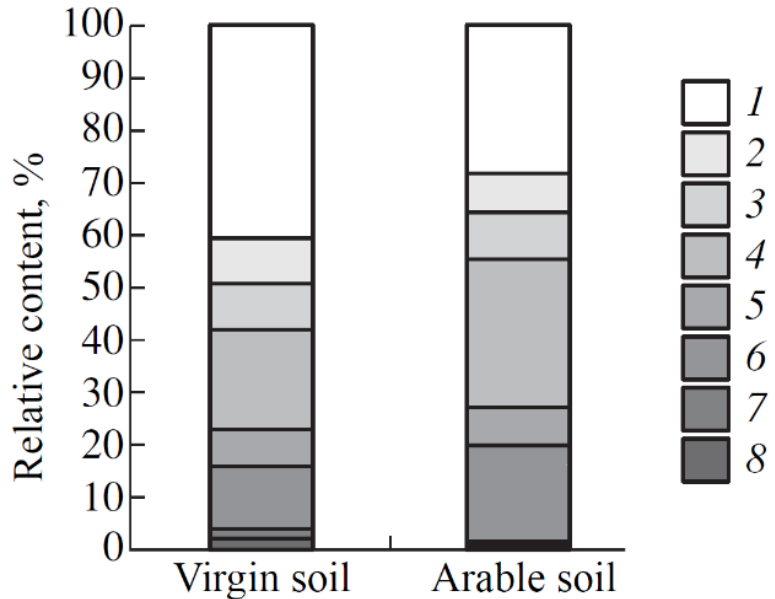
Figure 3. Relative content of structural fragments in HAs from mature and arable Retisols: aliphatic –CH, –CH 2 , and –CH 3 groups (1); amino group C and –O–CH 3 structures (2); carbohydrate, alcohol, and ether –C–O groups (3); aromatic C (4); phenol C Ar –O (5); –COOH groups (6); quinone C Ar =O (7) and aldehyde and ketone –C=O groups (8).